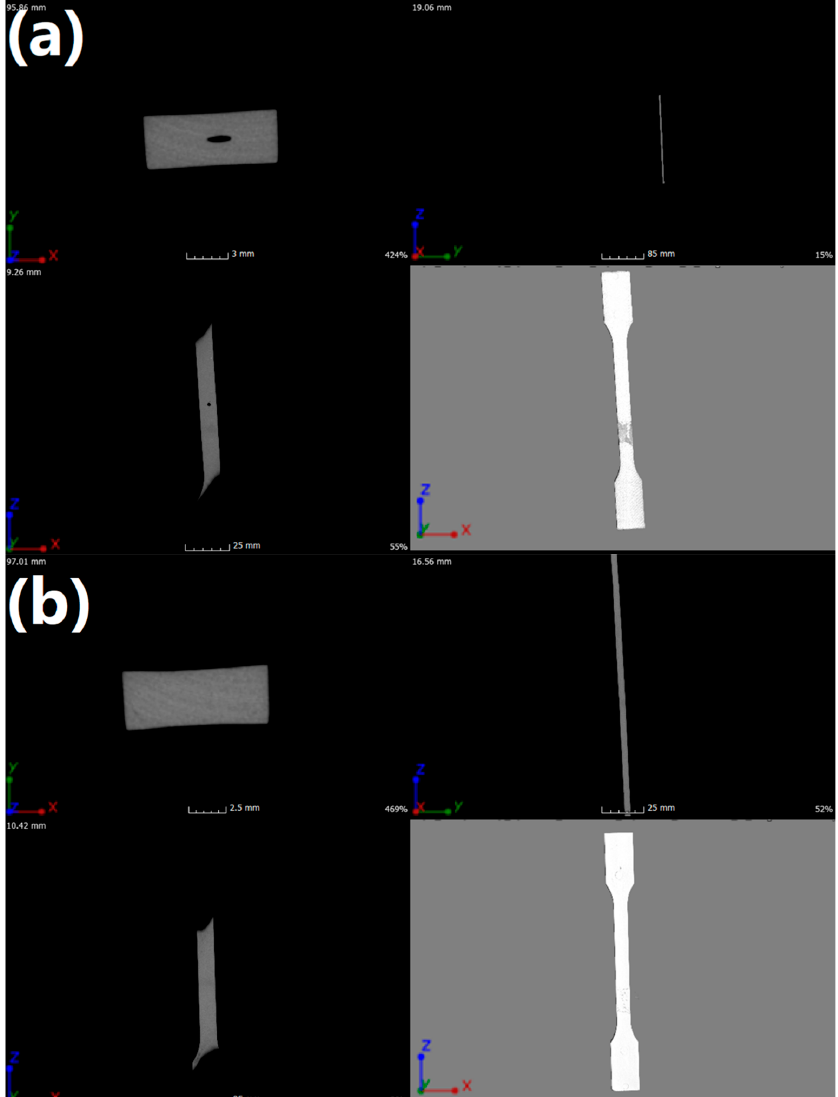
Figure 6. Images of ( a ) neat POM and ( b ) POM/5.0EVA samples obtained using µCT.